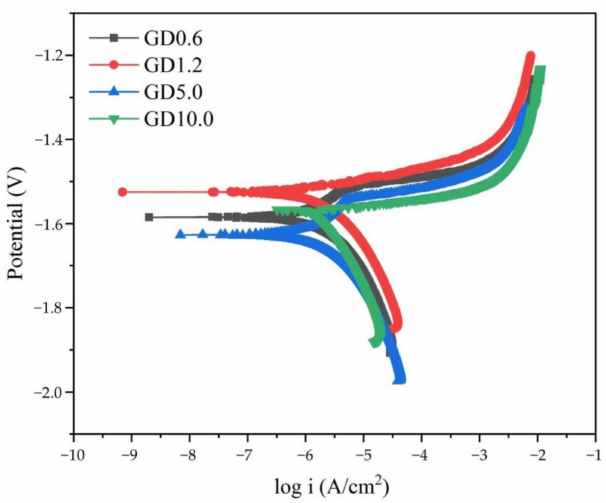
Figure 6. Potentiodynamic polarization curves of as-extruded Mg–Gd–Dy–Zr alloys in Hank’s solution. Table 3. The Tafel fitting parameters obtained from the potentiodynamic polarization